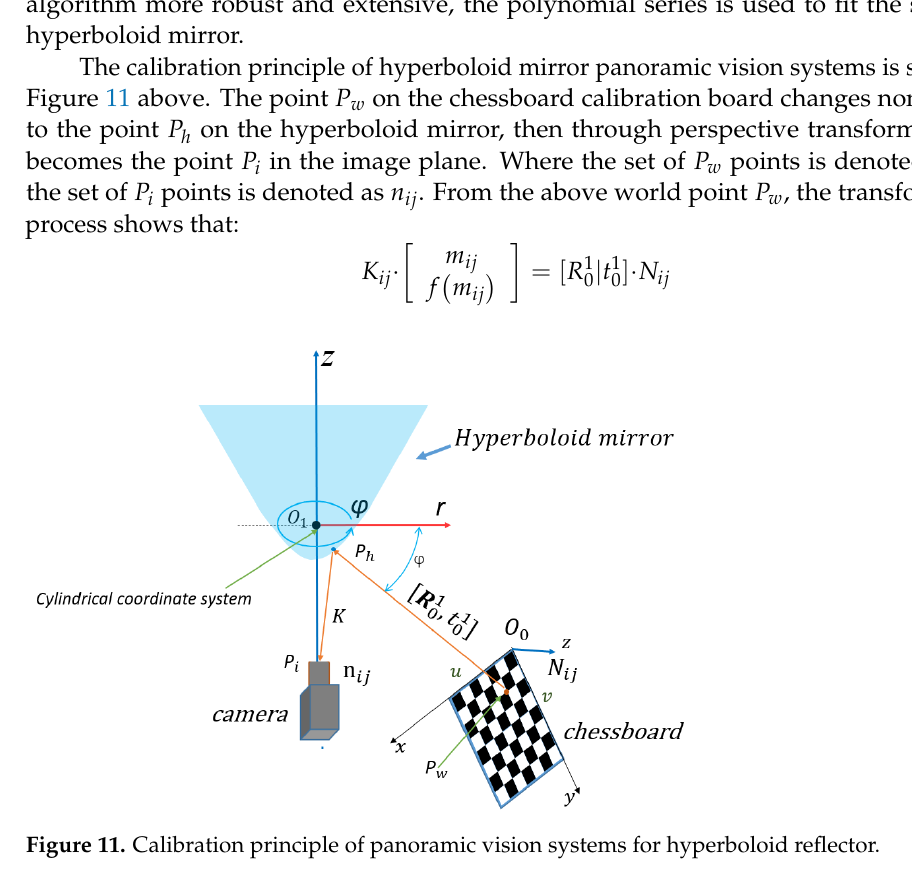
of 3 × 1, and 𝐾 𝑖𝑗 is the depth coefficient scalar, which is used to measure the world point P h . Thus, Equation (11) can be changed into Equation